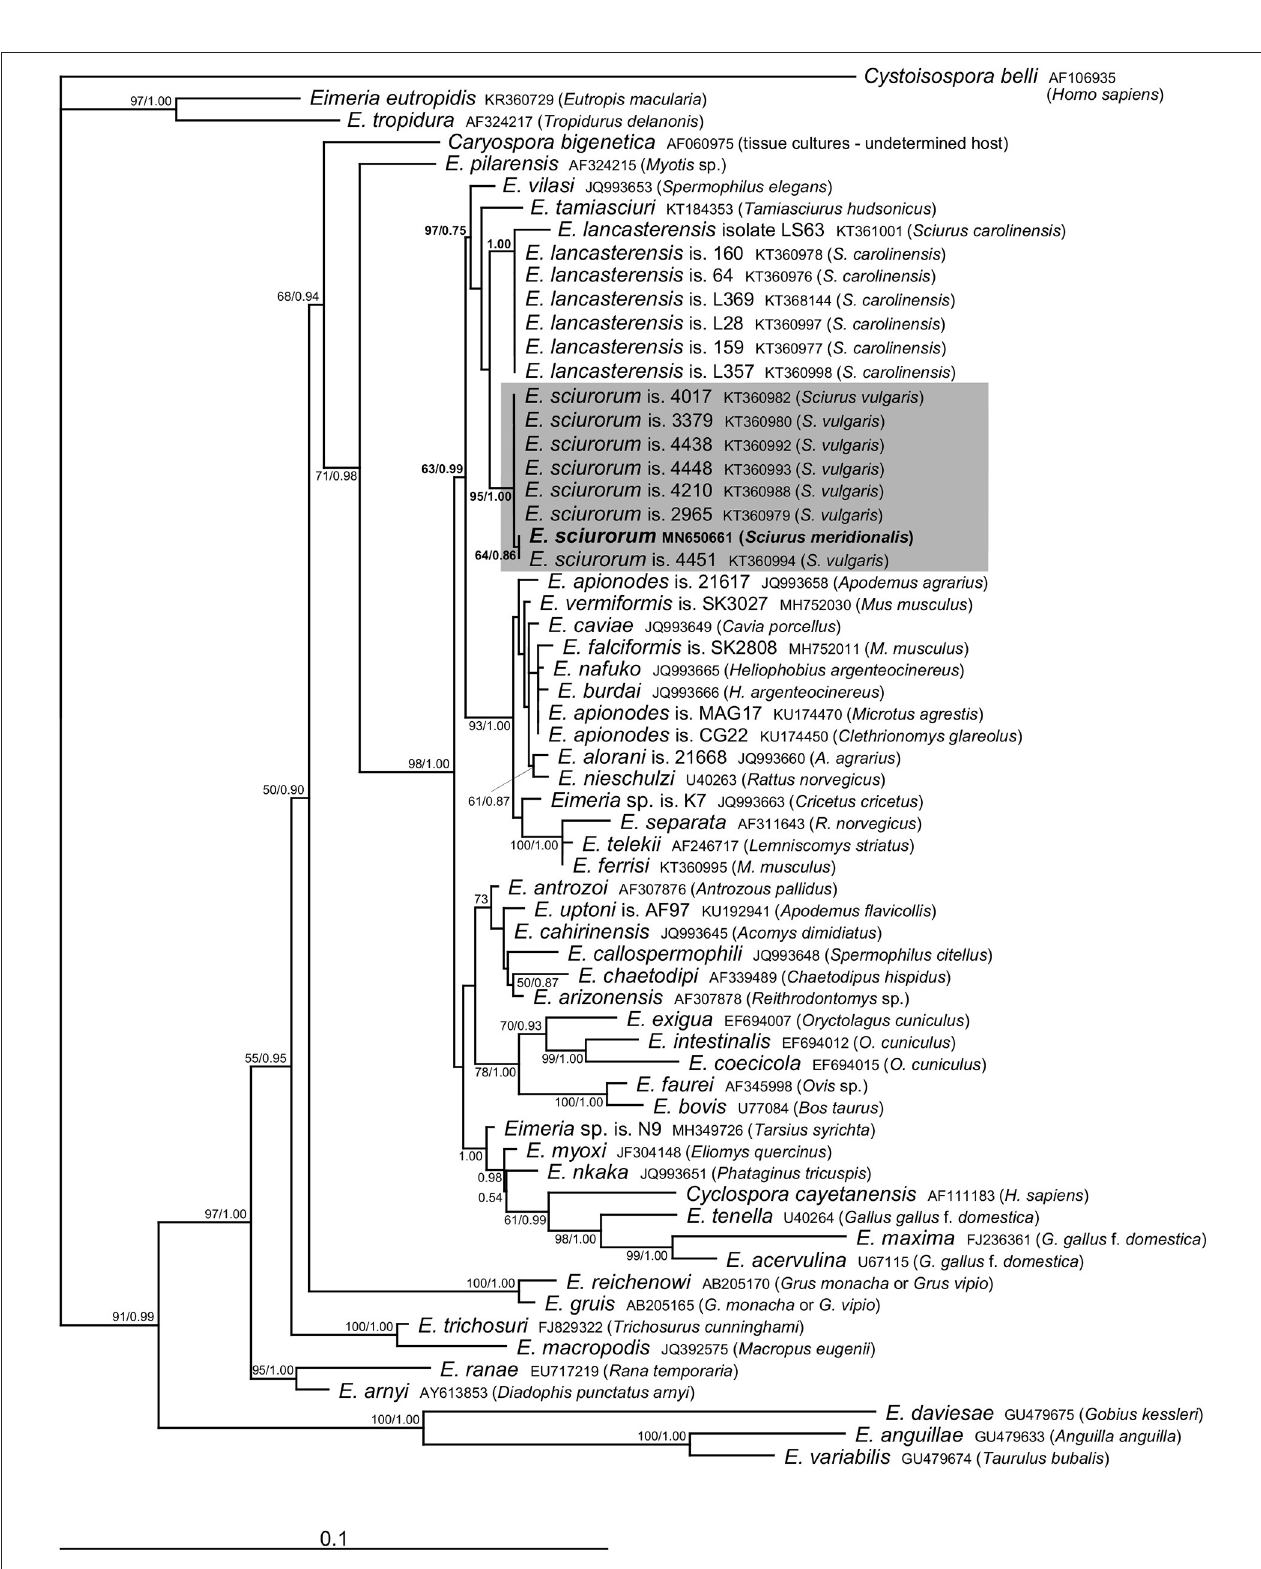
FIGURE 2 | Phylogenetic relationships inferred by the ML analysis of the 18S rDNA sequences. Numbers at the nodes show bootstrap values derived from ML analysis/posterior probabilities under the BI analysis. Bootstrap supports and posterior probabilities lower than 50% or 0.50, respectively, are not provided. The scale bar represents sequence divergence. Cystoisospora belli is used as an